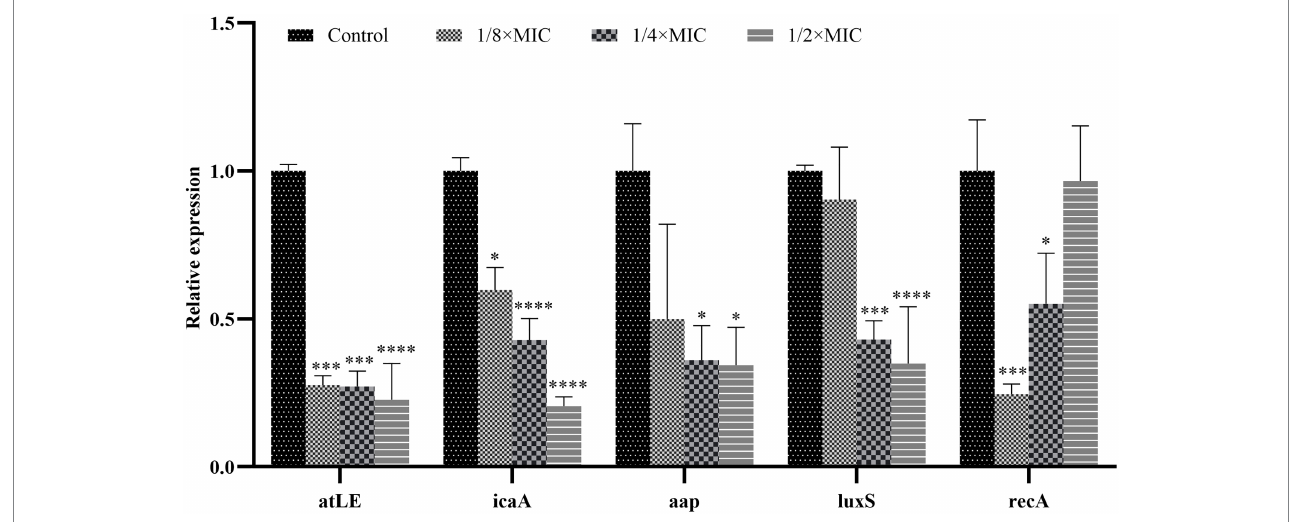
FIGURE 10 Expression of key genes in SEP-05 biofilm formation after Disaspidin BB intervention. * means p < 0.05, **means p < 0.01, ***means p < 0.001, ****means p <